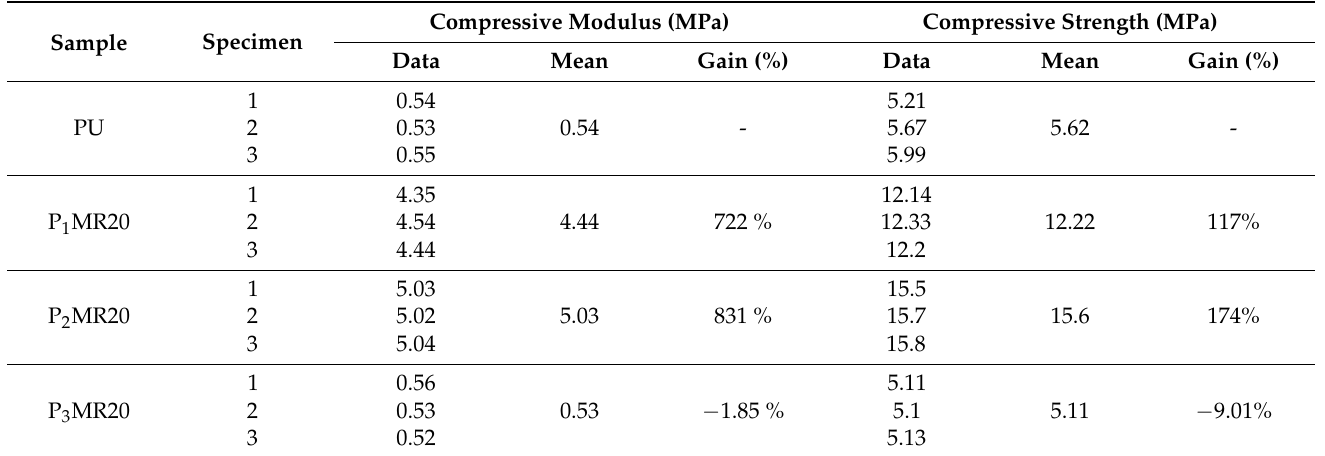
Table 5. A summary of the compression test